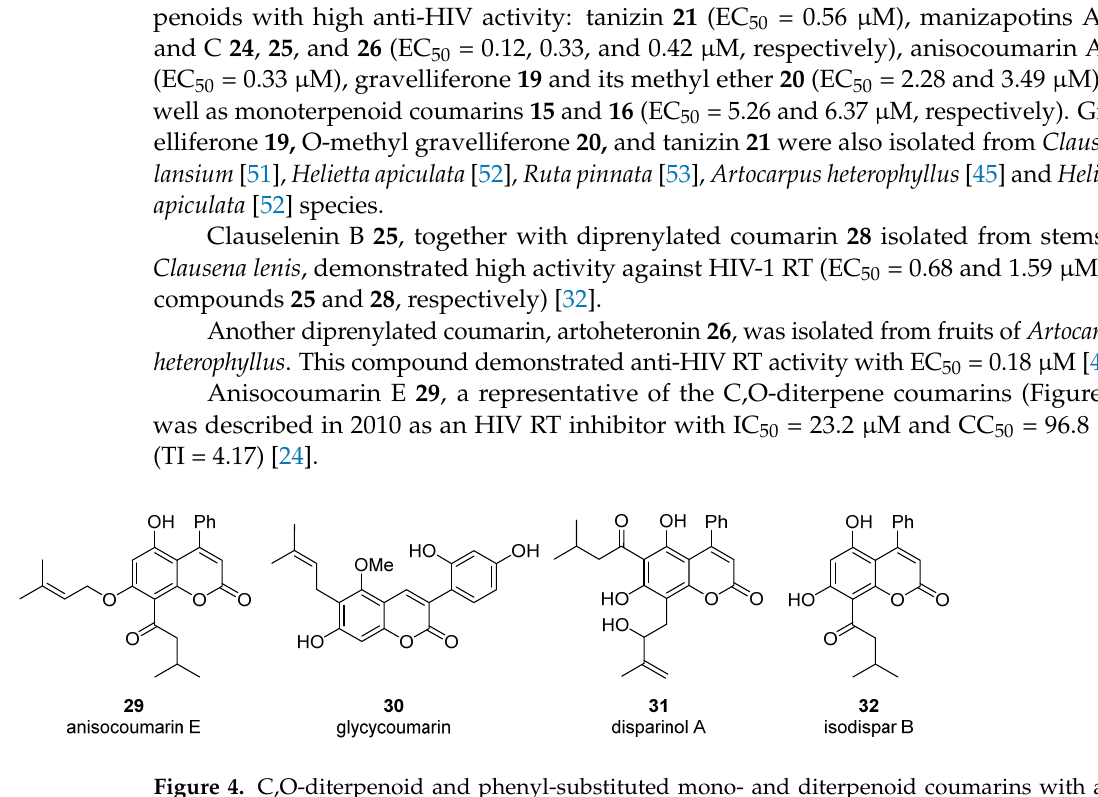
Figure 5. Structure of bichromonol 33 , a coumarin dimer .